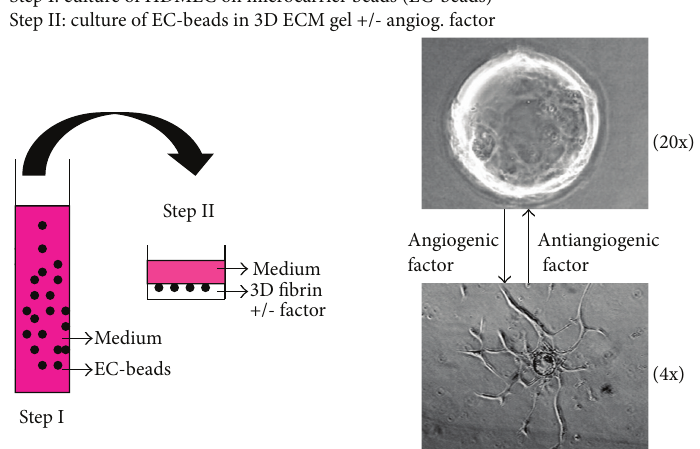
Figure 1: In vitro three-dimensional human angiogenesis model for assaying cell invasion, migration, and sprout angiogenesis formation of human dermal microvascular endothelial cells (HDMEC) (a). Step I: HDMEC are cultured on the surface of microcarrier beads to generate EC-beads. Step II: EC-beads are embedded in fibrin gel, collagen gel, or fibrin/collagen gel, with or without the presence of angiogenesis